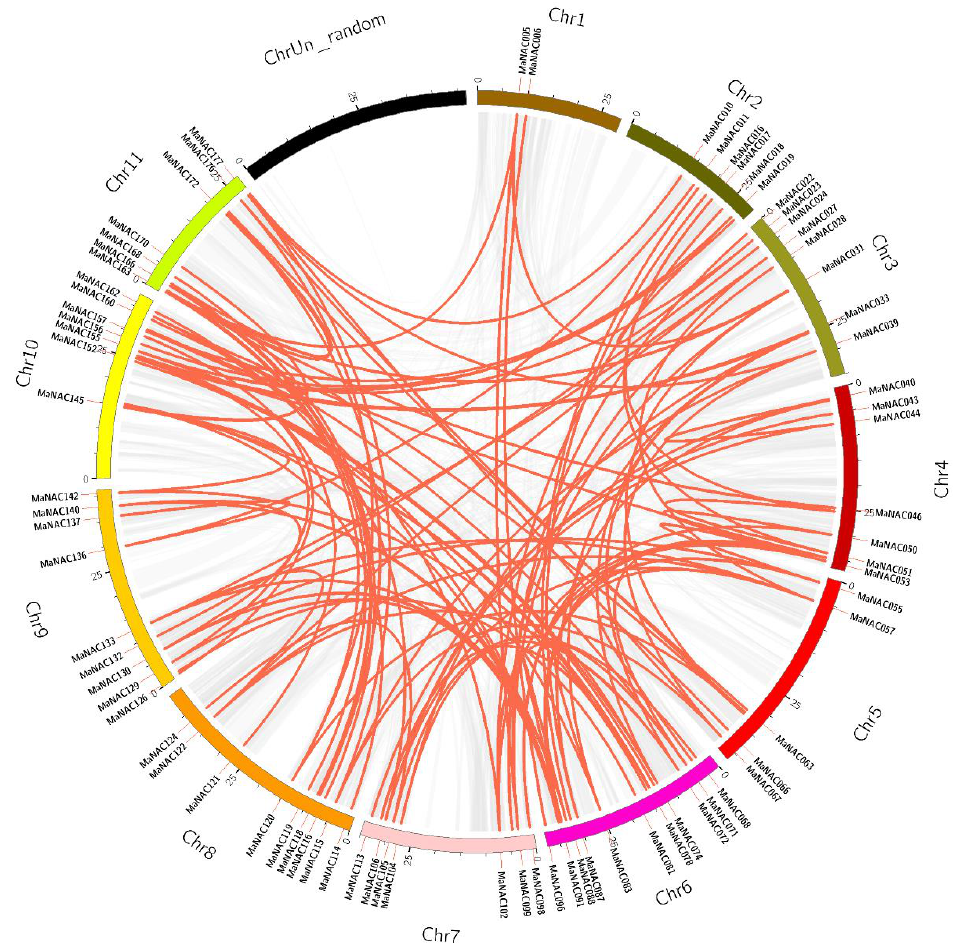
Figure 2. Schematic representation of the interchromosomal relationships of NAC genes in M. acuminata . Gray lines indicate all syntenic blocks in the banana genome, whereas orange lines suggest duplicated NAC gene pairs. The chromosome number is indicated at the top of each chromosome (color figure online).